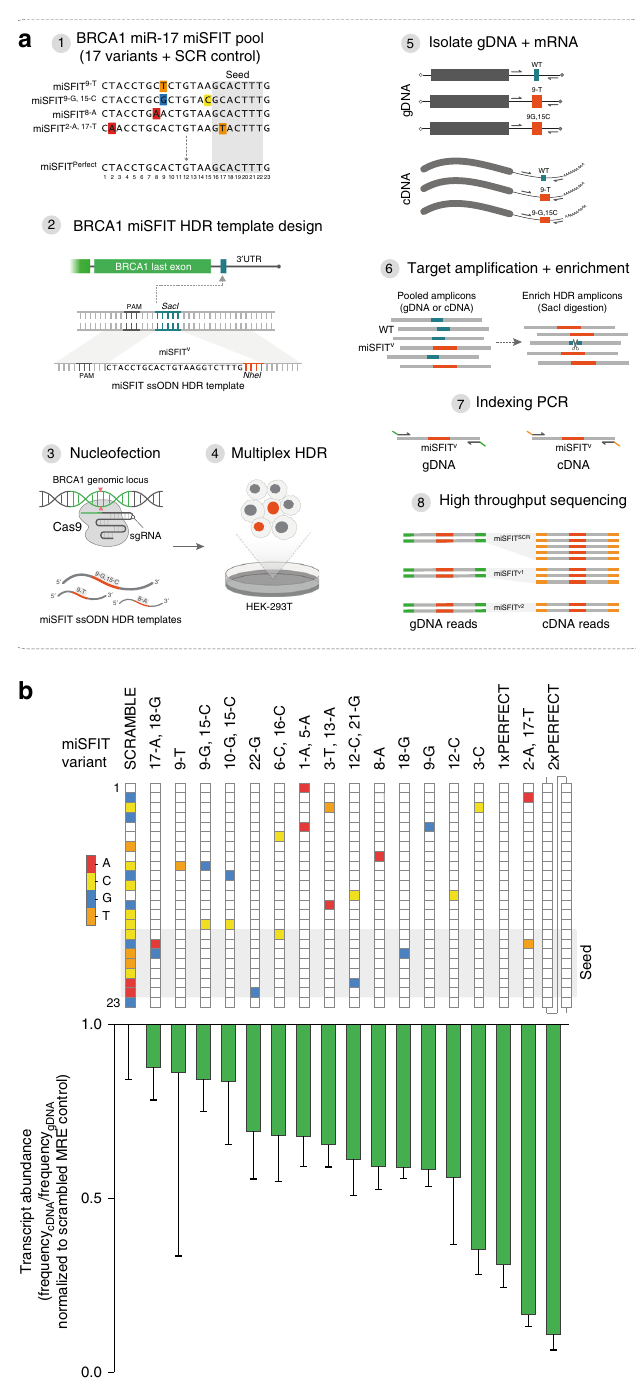
Fig. 5 CRISPR/Cas9-mediated miSFIT knockin enables fi ne-tuning of endogenous BRCA-1 expression. a Experimental work fl ow for tuning endogenous gene expression by genomic integration of miSFIT regulatory elements in the native 3 ′ UTR of a target gene using CRISPR-mediated HDR. Assessing the impact of miSFIT variants is carried out in a pooled format by high throughout sequencing. b Impact of a panel of 17 miR-17 miSFIT variants on endogenous BRCA-1 expression. ( n = 3 biological replicates, mean — s.d.). The position and identity of mismatched bases in each variant is indicated by the colour code. Bar plot re fl ects the degree of BRCA-1 repression imparted by each miSFIT variant relative to the scrambled MRE control. Source data are provided as a